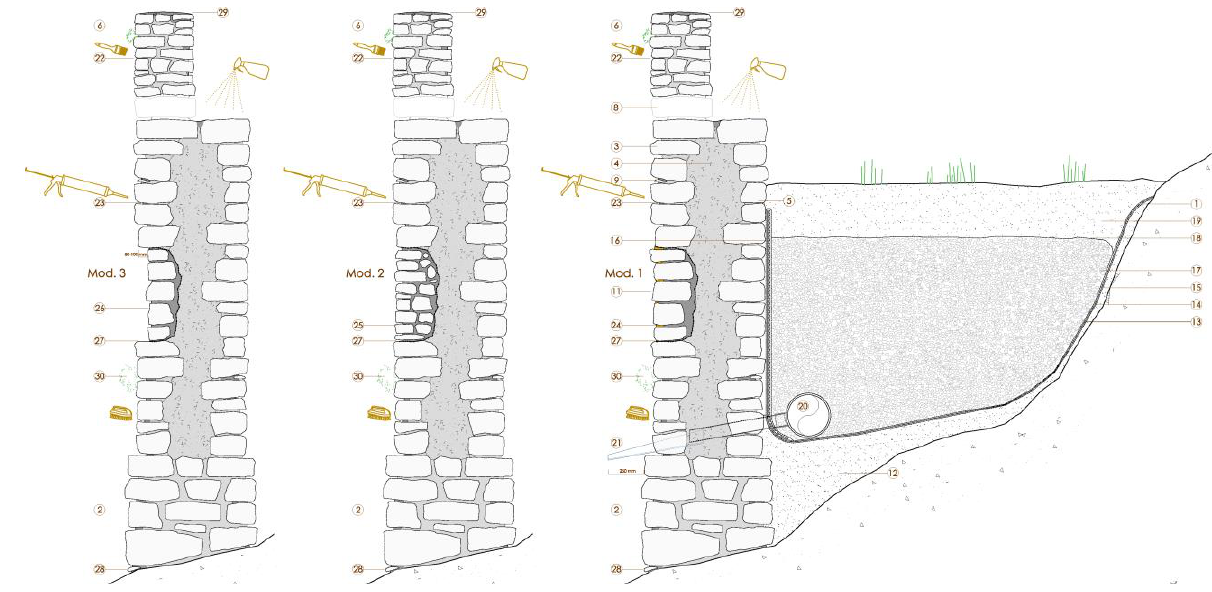
Figure 8. Detail of the project, showing the consolidation of the wall and the drainage of its inner face (Díaz and Baró,